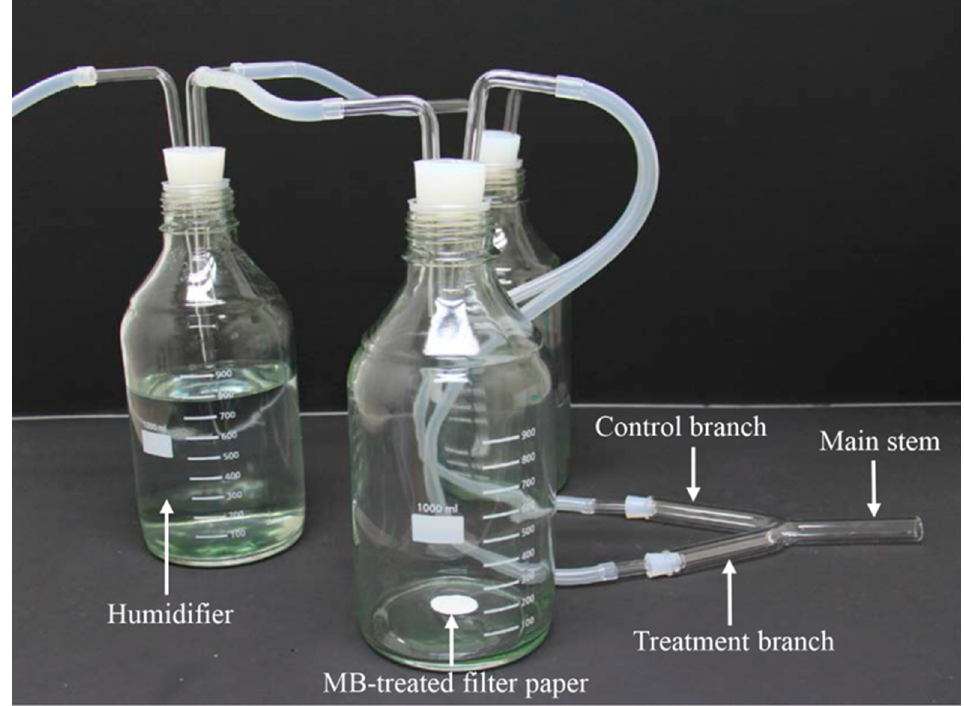
Figure 1. Y-tube olfactometer apparatus used to investigate the olfactory responses of adults of Nesidiocoris tenuis to methyl benzoate (MB).